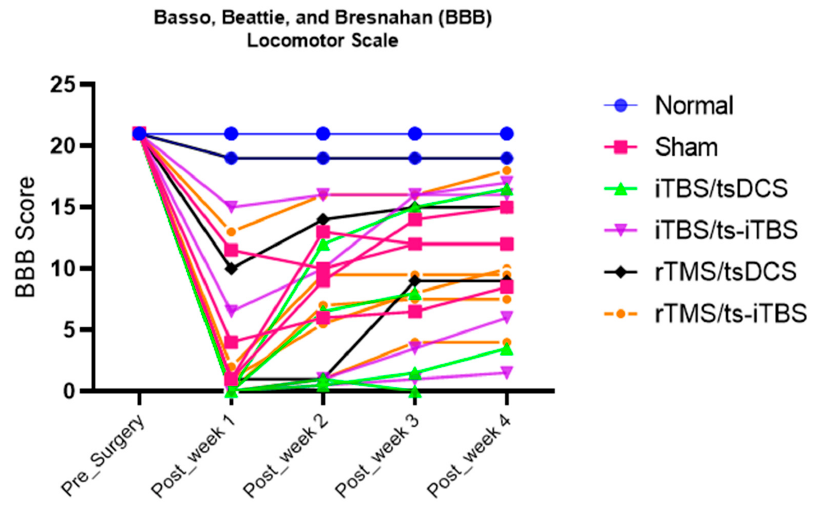
Figure 8. Basso, Beattie, and Bresnahan (BBB) scores for all six groups before surgery and week 1, week 2, week 3, and week 4 after stimulation interventions.